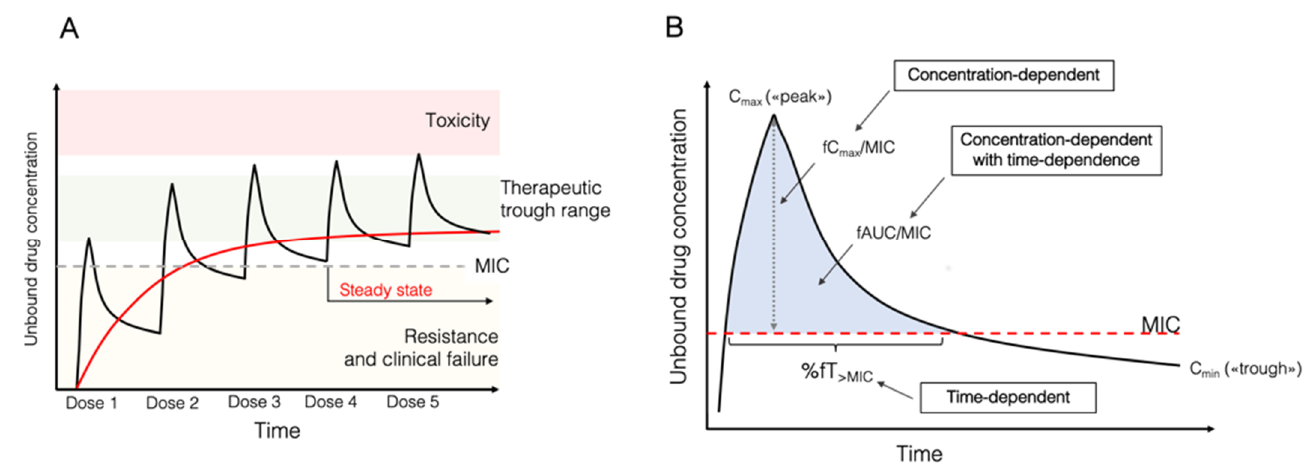
Figure 1. ( A ) Antimicrobial concentration–time curves. ( B ) Pharmacokinetic and pharmacodynamic parameters of antimicrobials at steady state. %fT >MIC , the percentage of time for which a drug’s con- centration remains above the minimum inhibitory concentration (MIC) for a dosing period; C max /MIC, the ratio of the maximum antimicrobial concentration (C max ) to MIC; fAUC/MIC, the